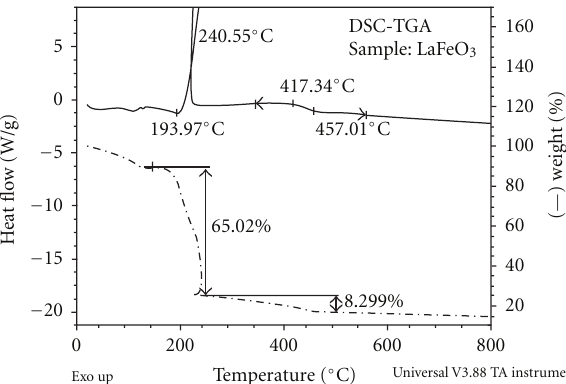
Figure 1: The DSC-TGA curves of the gel complex.